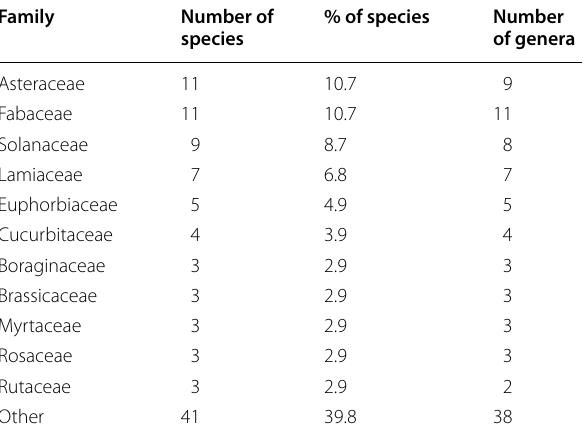
Table 1 Medicinal plant knowledge among different social groups of the study area ( n 367) = Parameter